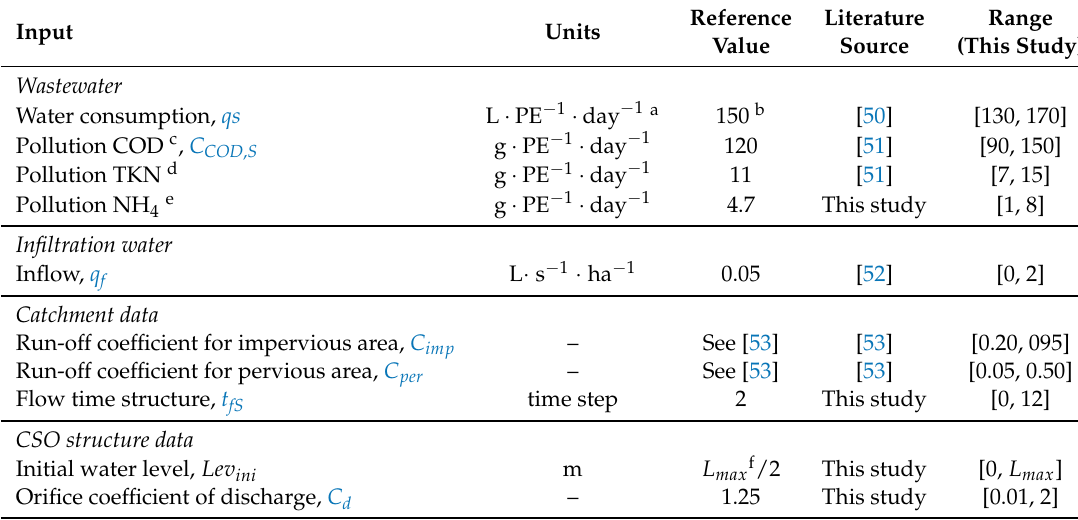
Table 2. Default values for input data of